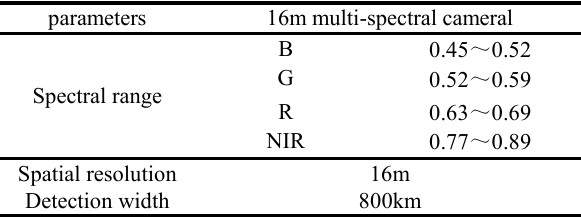
Table 1. The parameters of the satellite